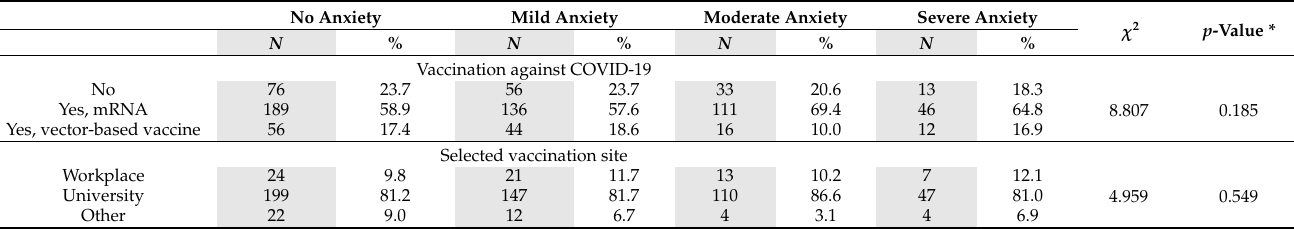
Table 2. Anxiety level and willingness to get a COVID-19